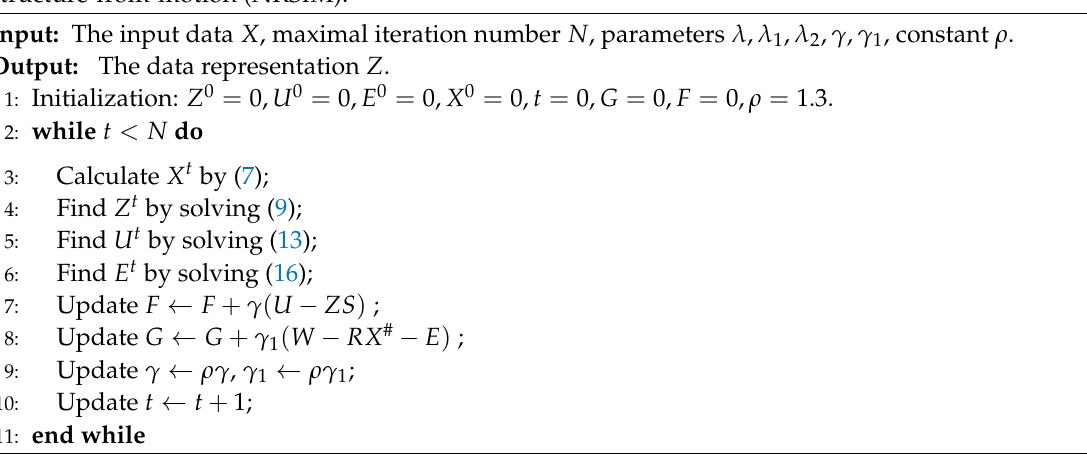
Algorithm 1 Solving data representation of the proposed ordered subspace clustering (OSC)-non-rigid structure-from-motion